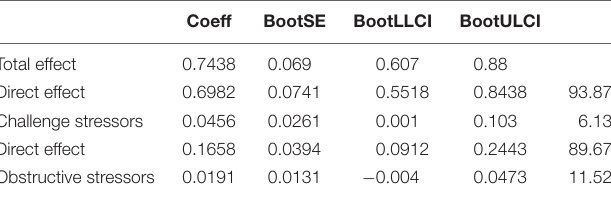
TABLE 4 | Mediating effect of stressors on social media